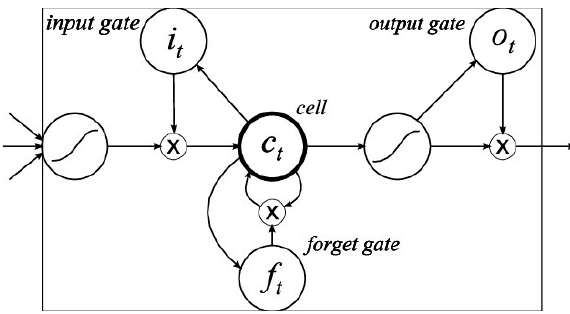
Fig. 1. Long Short-Term Memory